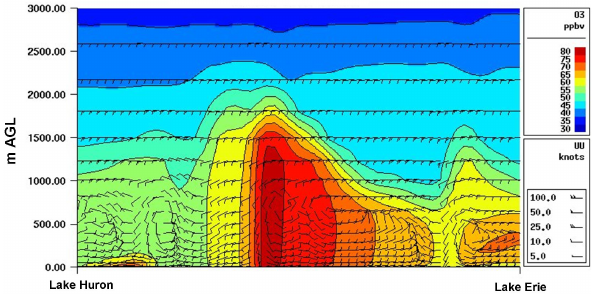
Fig. 14. Model-predicted ozone and wind fields, 8 July, 17:00 UT, Lake Huron to Lake Erie